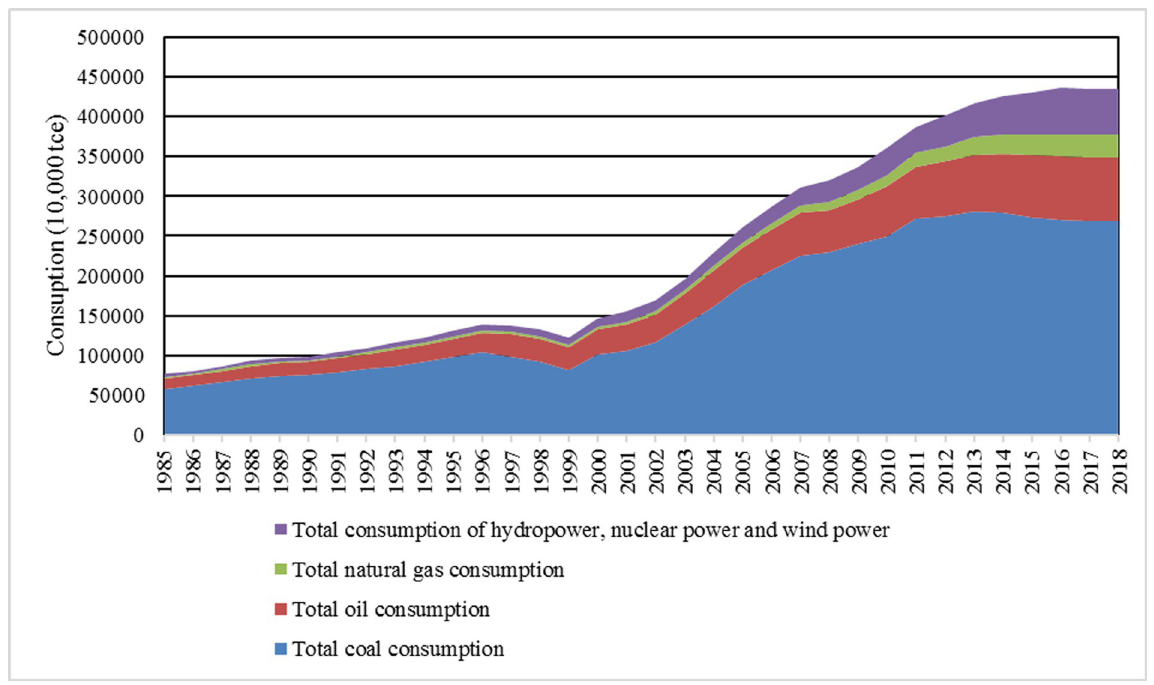
duction and consumption have been reduced, while clean energy has been greatly developed.